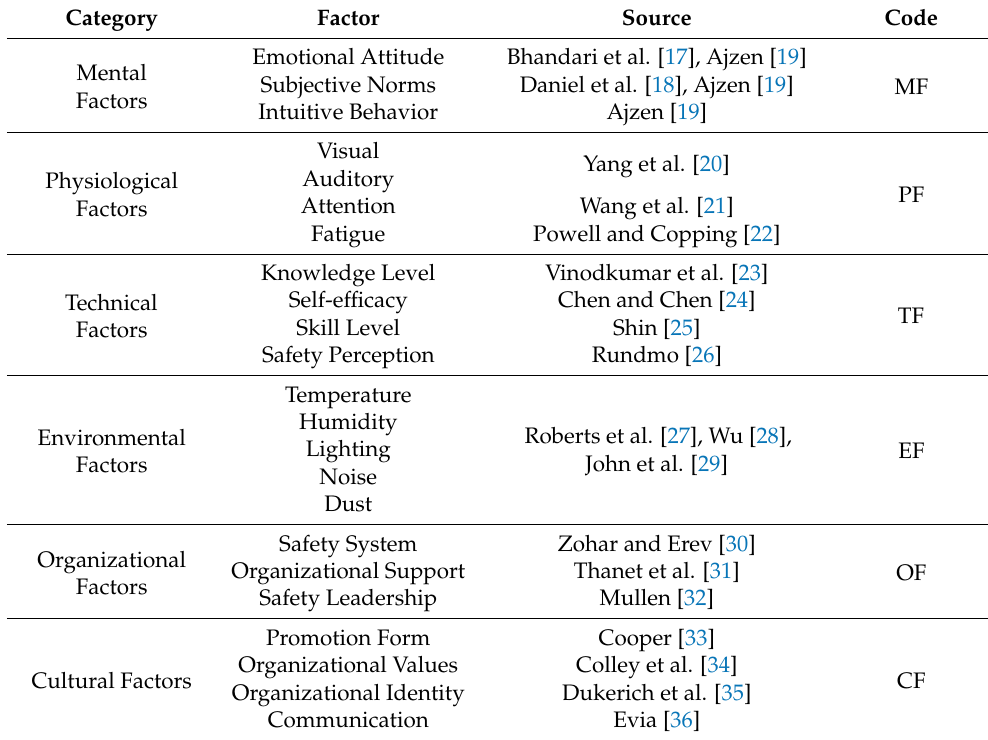
Table 1. Identification and classification of human error